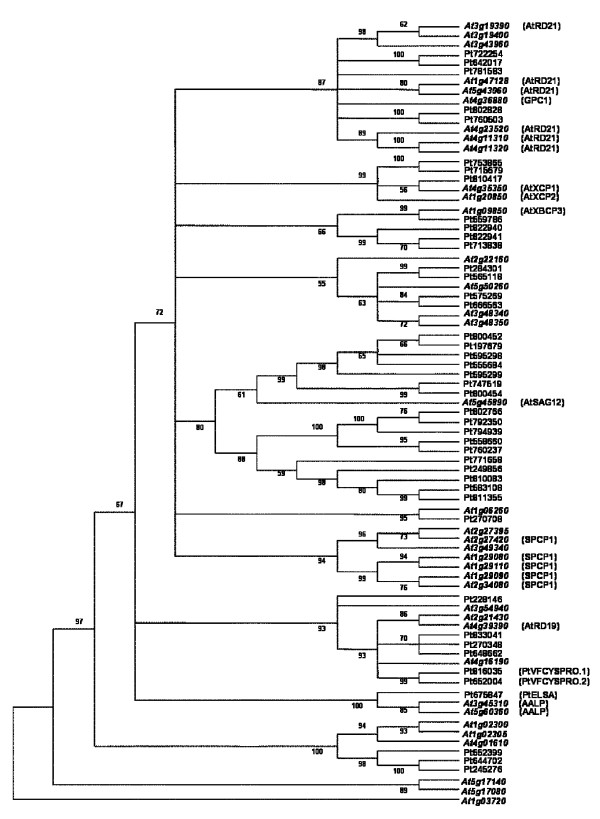
Maximum Parsimony Tree of the papain-like protease family (C1 family in MEROPS). RD, Response to Dehydration; GPC, Germination-specific Cysteine protease; XCP, Xylem Cysteine Protease; XBCP, Xylem and Bark Cysteine Protease; SAG, Senescence-Associated Gene; SPCP, Sweet Potato-like Cysteine Protease; (VFCYSPRO) Vicia faba CYStein PROtease; ELSA, Early Leaf-Senescence Abundant cysteine protease; AALP, Arabidopsis Aleurine-Like Protease. The names and the accession numbers for the different proteins are given in Table 7.